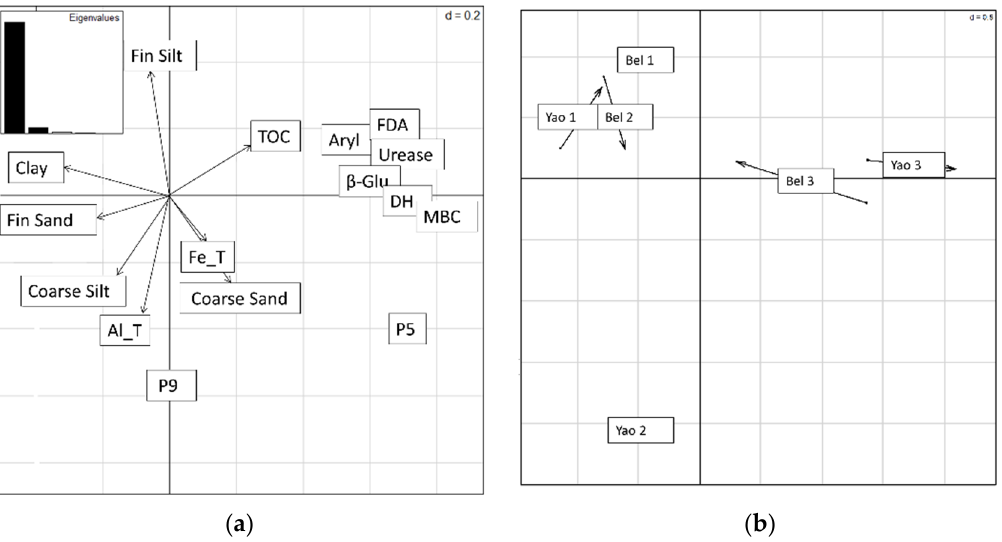
Figure 3. ( a ) Co-inertia analysis between soil physico-chemical parameters and microbiological variables. The variables linked by lines refer to the physico-chemical variables, the other variables refer to the different enzymes activities and microbial biomass in the soil sample; ( b ) discriminant analysis on co-inertia variable of soil samples. Boxes represent the projected co-ordinates of physico-chemical dataset and microbial dataset of each rehabilitated site, respectively. The length of the arrow is proportional to the divergence between the data sets. Eigen values 86.74% and 9.08% for axis 1 to 2, respectively. Randtest: simulated p -value: 0.0019. Explained variance: 41.81%.